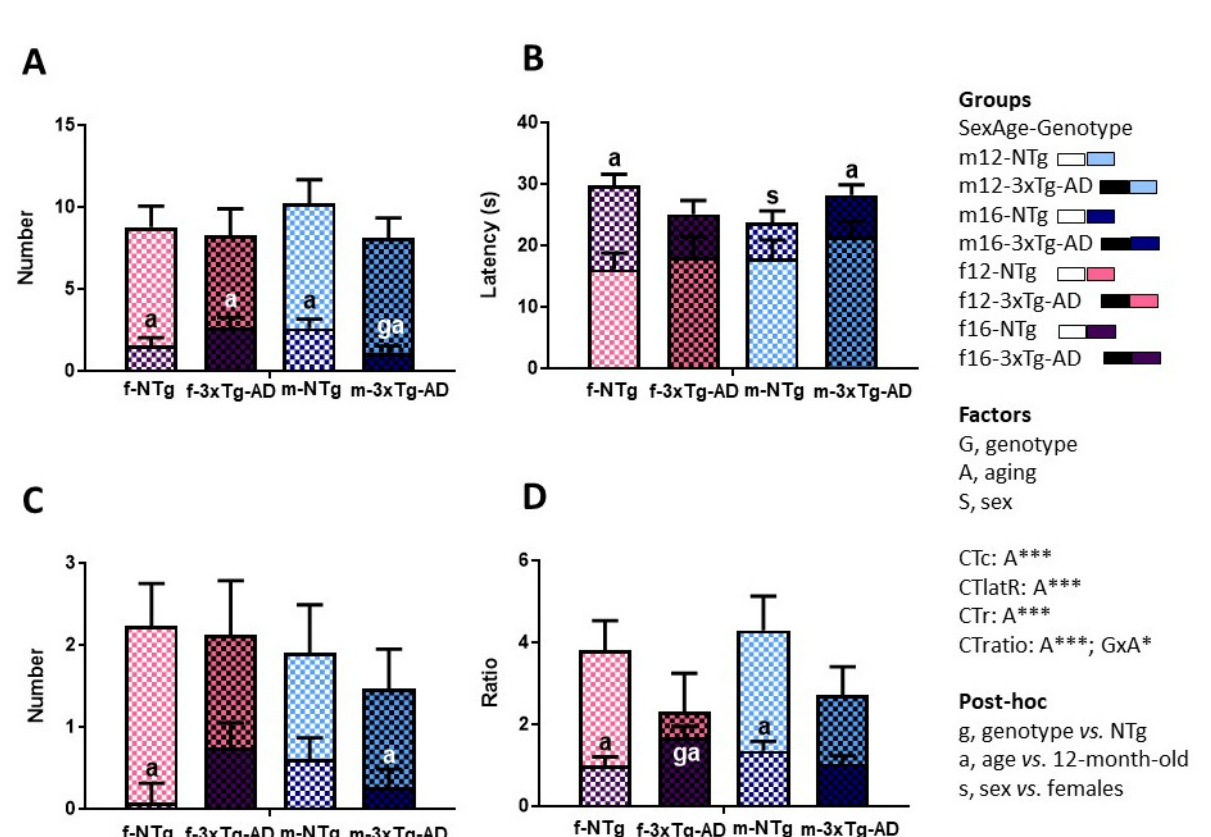
Figure 2. Sex and age effects in the longitudinal assessment in the corner test in mice with normal and AD-pathological aging. ( A ) Number of crossings (CTc); ( B ) Latency of rearing (CTlatR); ( C ) Number of rearings (CTr); ( D ) Ratio CTc/CTr (CTratio); Factorial analysis: G, genotype (NTg, 3xTg-AD mice); A, aging (12, 16 months of age); S, sex (male, female). * p < 0.05; ** p < 0.01; *** p < 0.001. Table 1. Post-hoc analysis of genotype, sex, and aging differences in the corner test.